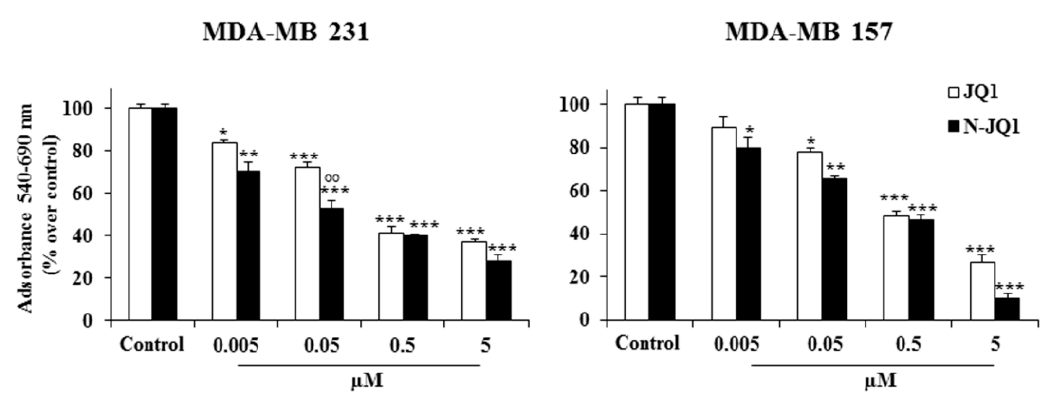
Figure 2. E ff ects on TNBC cell viability. MDA-MB 231 and MDA-MB 157 cells were treated with JQ1 diluted in PBS + 5% PEG 400 + 5% TWEEN (JQ1) or encapsulated in nanoparticles (N-JQ1). E ff ects on